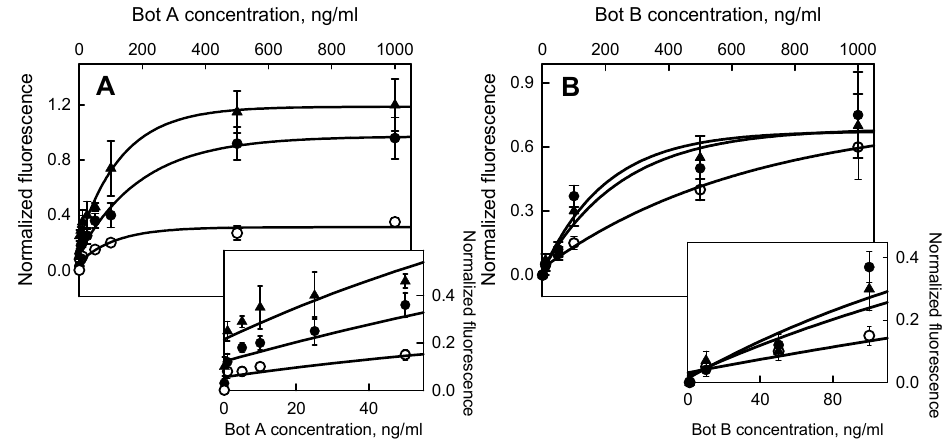
Figure 2 . Dose response curves for botulinum toxoids A (a) and B (b) in sandwich format assays. Shown are binding of inactivated toxins to polymyxin B ( ○ ), cecropin A ( ▲ ), and anti-botulinum toxin A/B ( (cid:122) ). Data shown were normalized with respect to chicken positive control signals to account variability between the slides. Error bars represent standard deviations (n ≥ 4 replicate